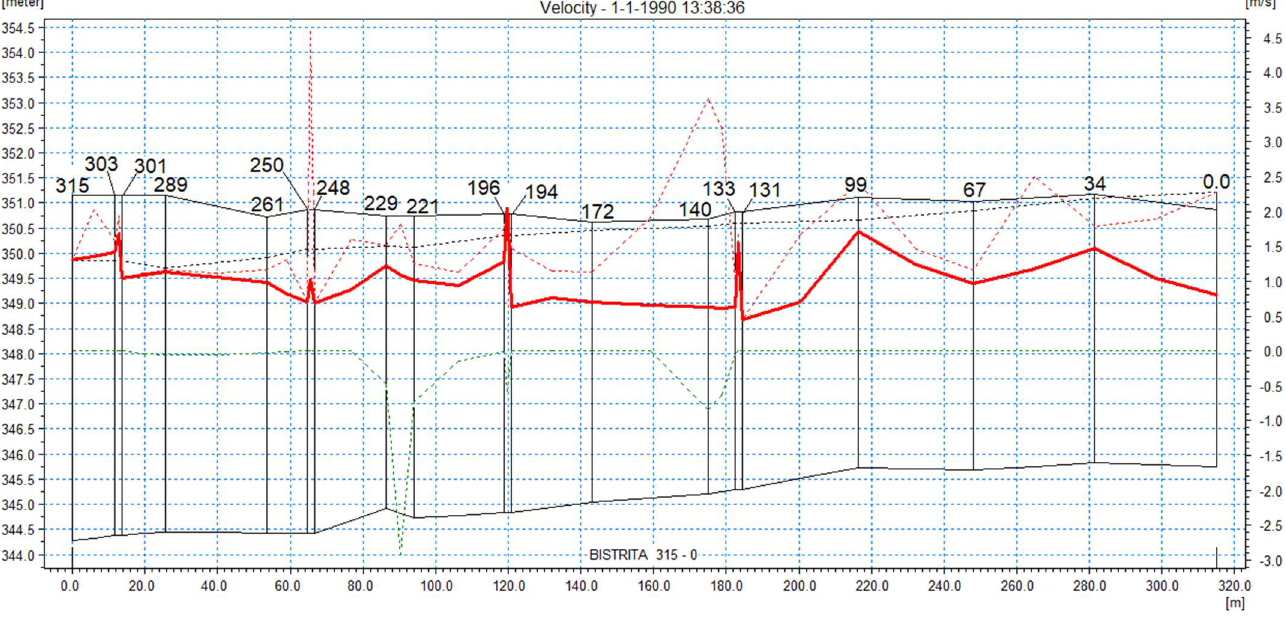
Figure 15. Water speed for flow Q = 8.37 m 3 /s, the average annual flow calculated for the year 2021. For the proposed case with the lowering of the crest of the existing weir and the construction of three new weirs of low height downstream of it.